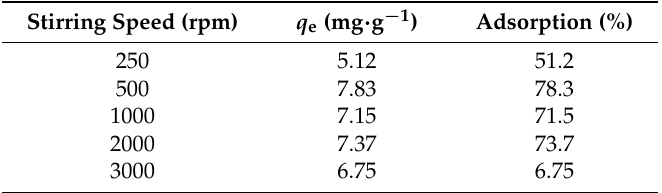
Table 2. Effect of the stirring speed on the Cu 2+ adsorption onto the CNF. Experimental